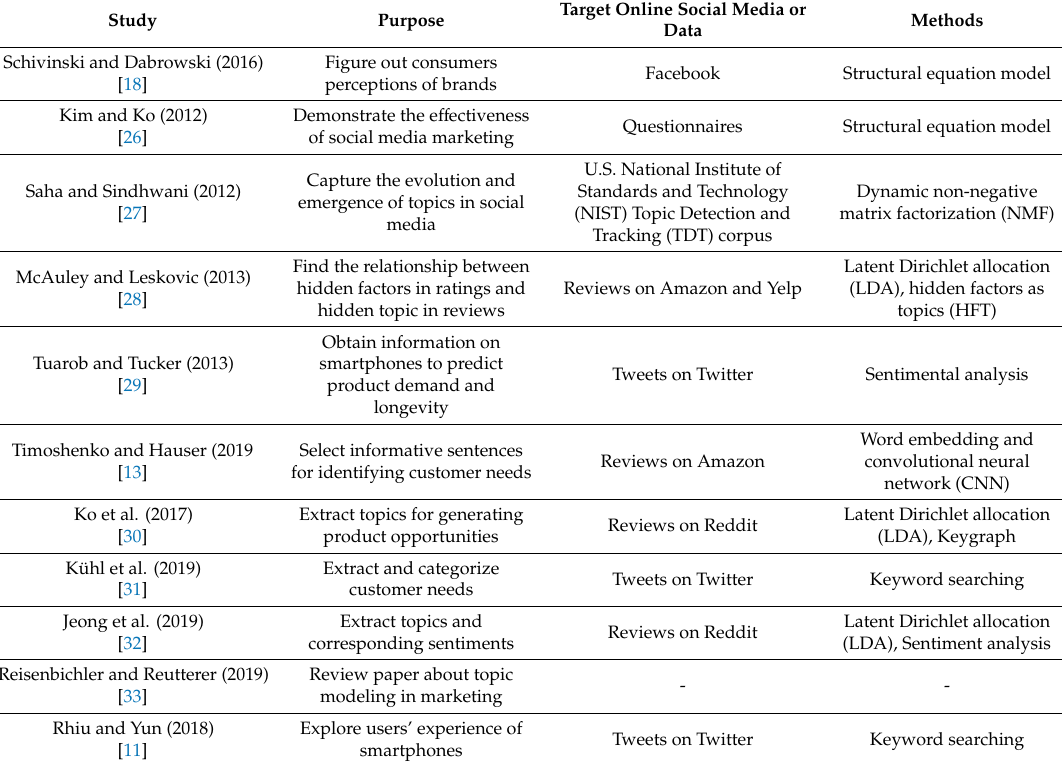
Table 2. Related studies using online social